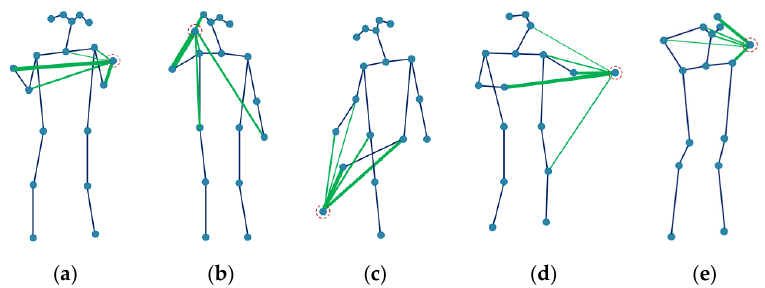
Figure 6. Visualization of relations between the specific joint that circled with dash line and other joints with AAM-GCN. ( a ) clapping; ( b ) talking on the phone; ( c ) kicking; ( d ) beating; ( e ) comb hair.